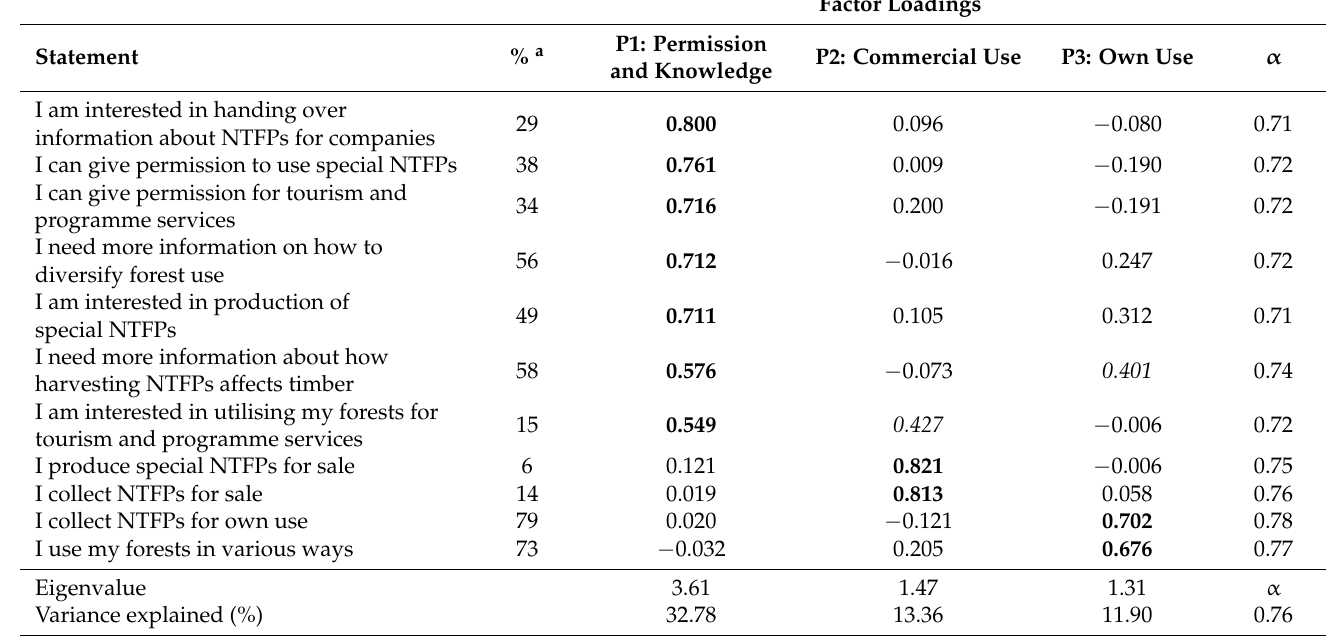
Most forest owners stated that they use their forests in various ways (Table 5). As many as 79% of the forest owners collected berries and mushrooms for their own use, but only 14% collected them for sale, and only 6% produced special natural products for sale. However, half of the respondents were interested in the production of special NTFPs, which can be collected only with the forest owner’s permission. More than a third of the respondents were willing to give permission to use their forests for special NTFPs. Table 5. Principal component analysis of the statements concerning utilisation of NTFPs (n = 2253). The principal components explained 57.3% of the total variance and are called P1 = Permission and knowledge; P2 = Commercial use; P3 = Own use. Absolute loadings > 0.5 are in bold and 0.4–0.5 in italics. α = Cronbach’s